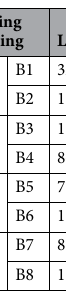
Table 10. Bearing lifetime of modified gearbox in